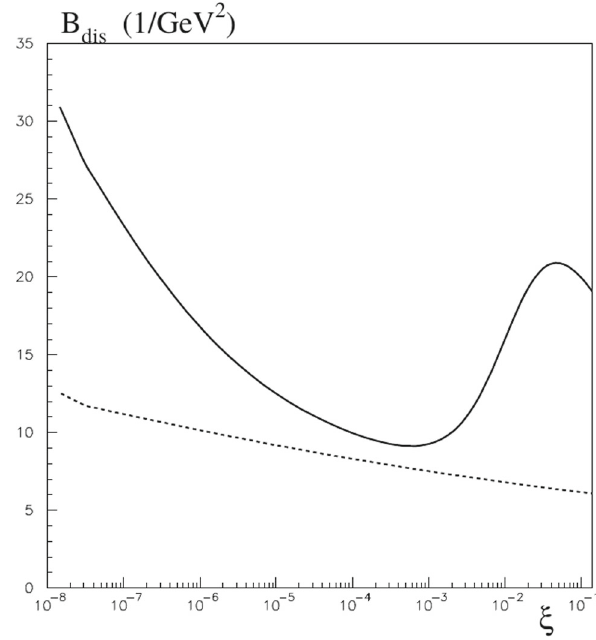
Fig. 11 The ξ dependence of the t -slope B dis ( t = 0 ) in the single √ s = 13 TeV. The dashed curve is the proton dissociation process at Pomeron component while the continuous curve includes secondary Reggeon contributions. Note that here we show the slope at t = 0. As it is seen from Fig. 10 the mean slope (within a larger | t | interval) is a bit smaller